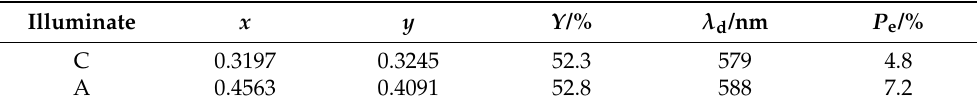
Figure 4. Reflectance of siderazot showing a constant increase with wavelength. Filled symbols are extrapolated wavelengths, open circles measured. Unoriented sample. Table 2. Calculated color values of siderazot: x , y (chromatic coordinates), Y (luminance), λ d (dominant wavelength), and P e (excitation purity).